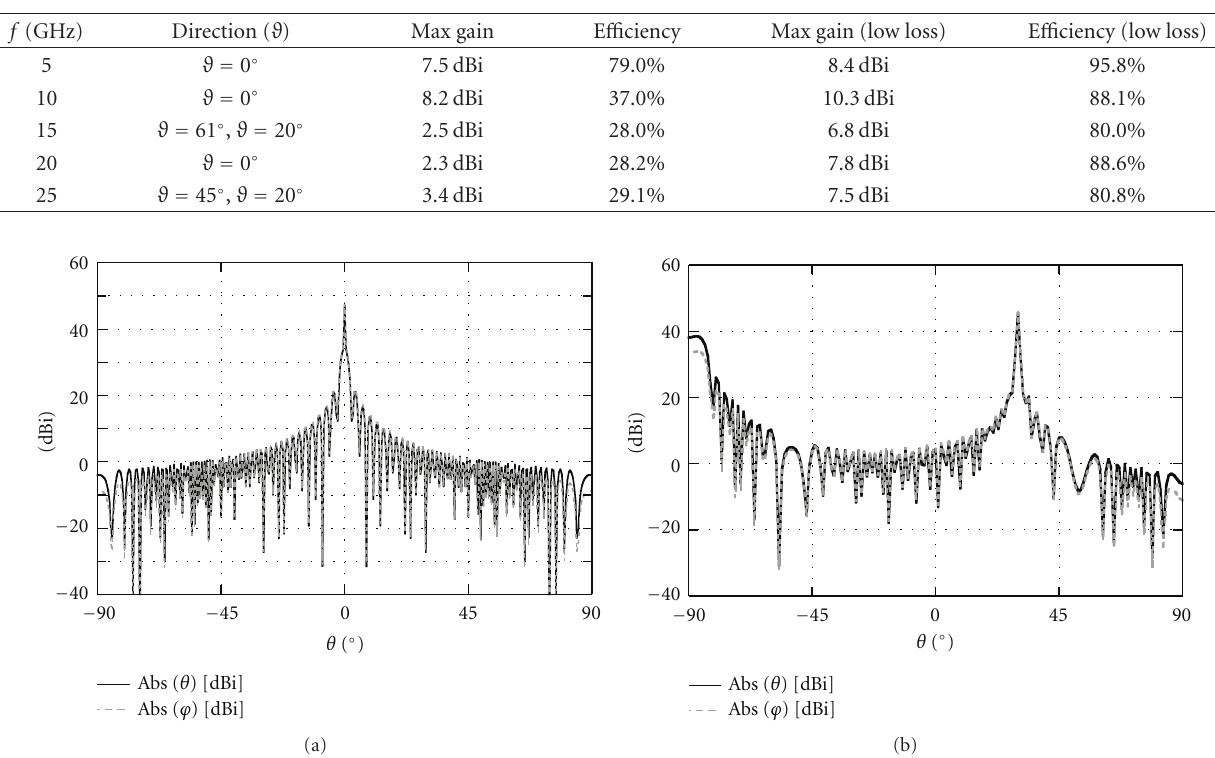
Figure 8: Array of shielded elements as in Figure 2. Gain on the principal elevation plane φ = 0 ◦ of a 140 × 140 array at 5GHz. All the ports are fed, exciting a circularly polarized field (its θ component in solid black line , its ϕ component in dashed gray line ). (a) Beam pointing at broadside ( θ = 0 ◦ ). (b) Beam pointing at θ = 30 ◦